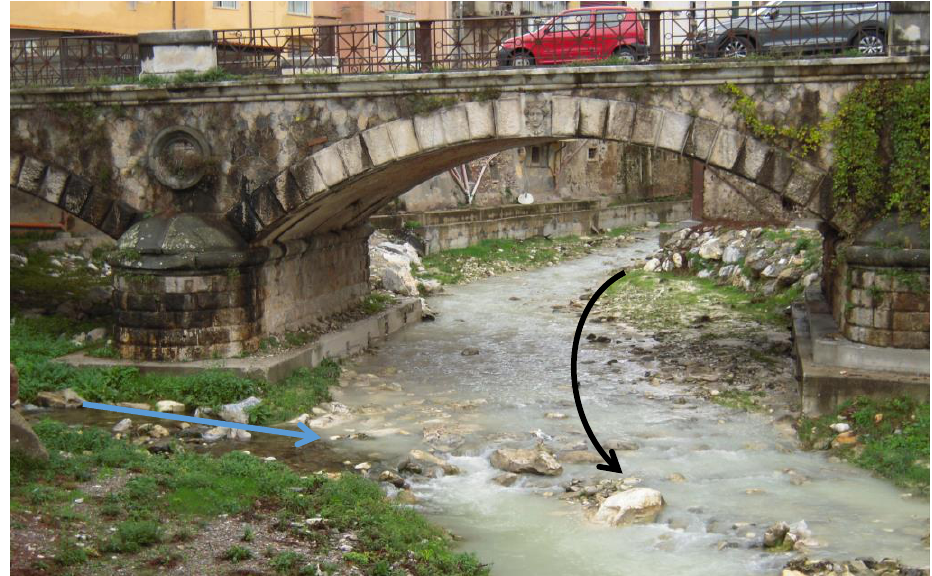
Figure 2. On the right (black arrow), the Carrione torrent turns whitish after a rain for the presence of marmettola, coming from the upstream quarrying area (Carrara, Italy); on the left, blue arrow indicates clear water coming from an area without quarries.